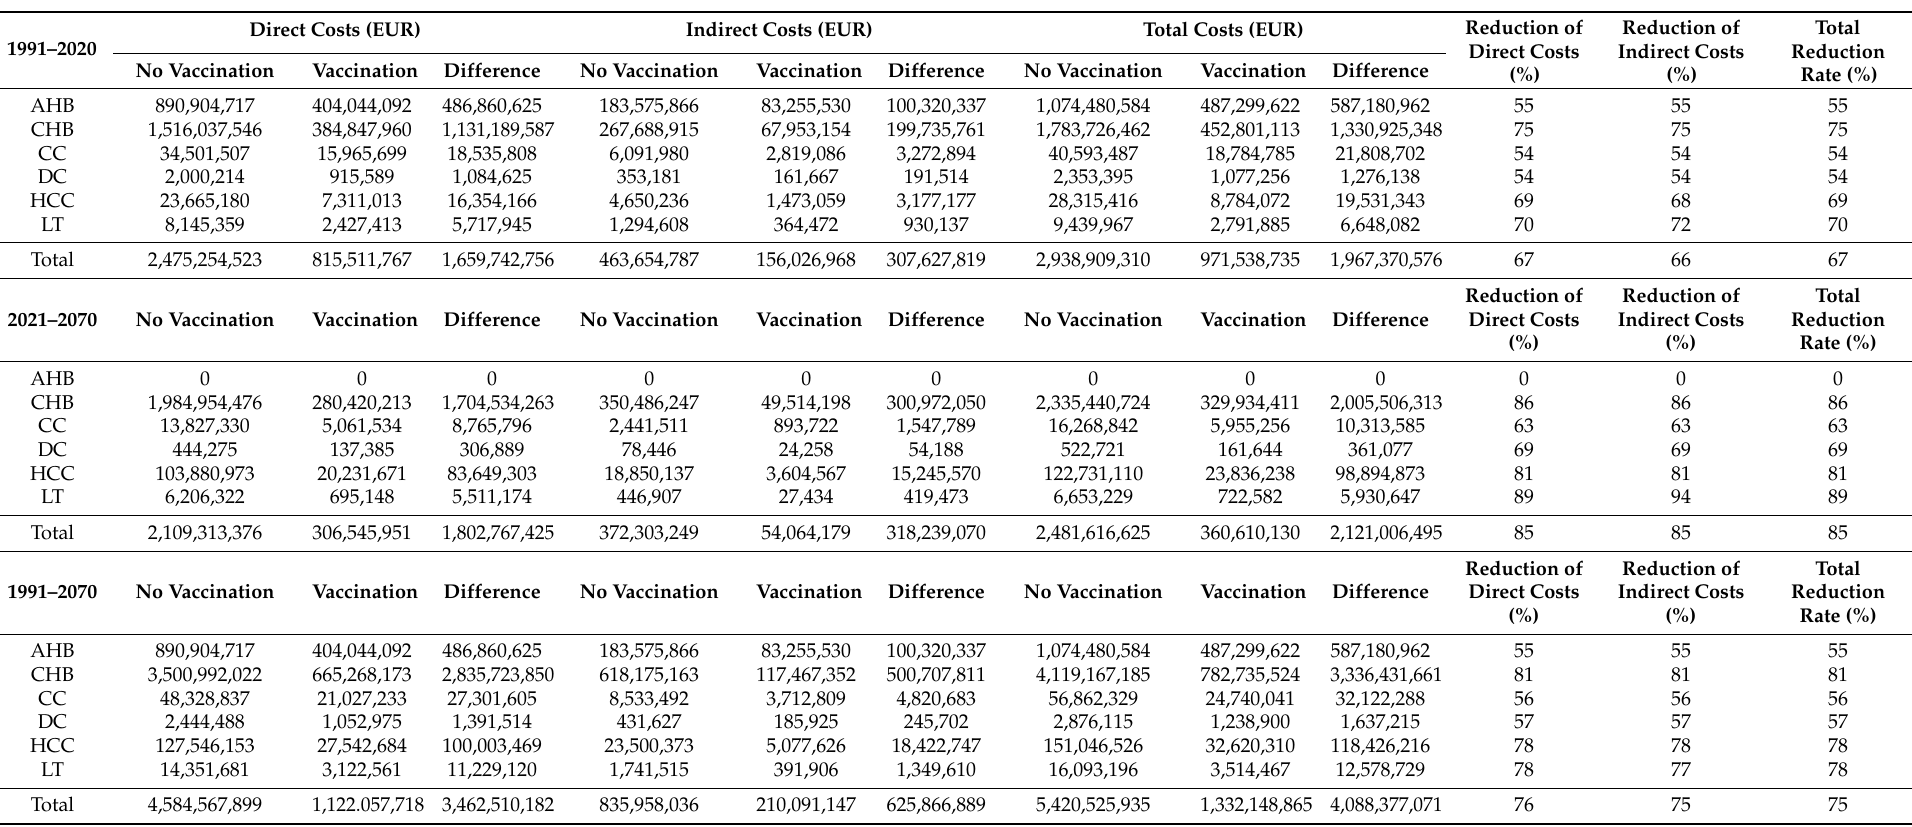
Table 4. Direct, indirect and total clinical-costs (in euros) during the period 1991–2020, 2021–2070 and 1991–2070 in the no-vaccination and vaccination